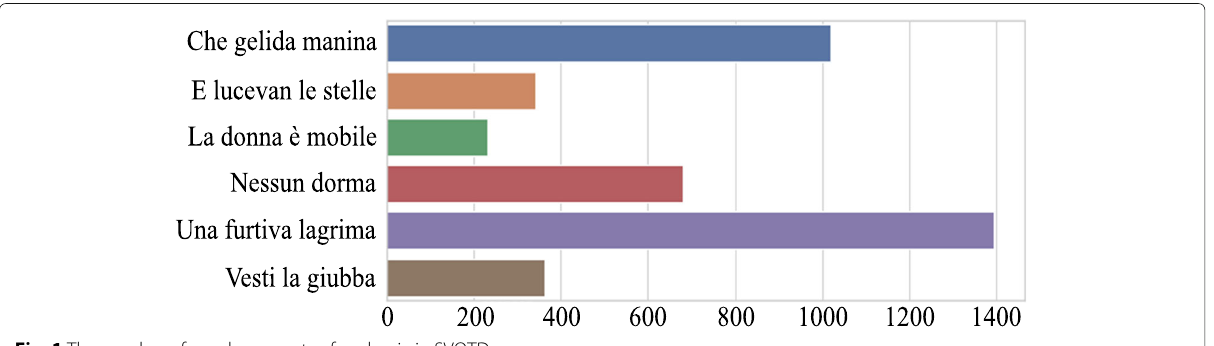
Fig. 1 The number of vocal segments of each aria in SVQTD